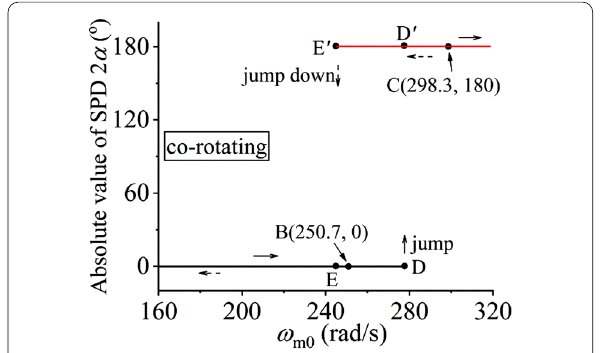
Figure 4 Absolute values of SPD versus ω m0 for two co-rotating